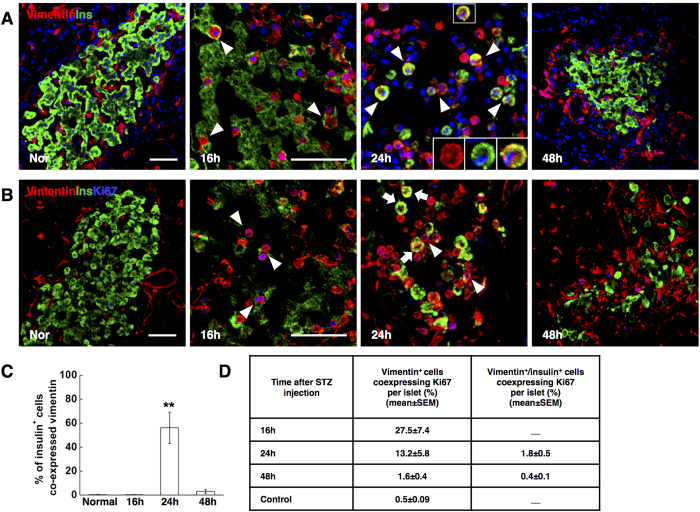
Neogenic beta-cells manifested vimentin expression.(A) Photomicrographs double stained with anti-insulin (green) and anti-vimentin (red) antibodies from normal control rats (Nor), and STZ-treated rats at different time points (16 h, 24 h, 48 h). Nuclei were labeled with DAPI. Scale bars, 50 μm. The isosceles triangle: insulin+ cells co-expressing vimentin. The boxed regions showed the high power photomicrograph at the bottom right of the image. (B) Photomicrographs triple stained with anti-vimentin (red), anti-insulin (green) and anti-Ki67 (blue) antibodies. The isosceles triangle: vimentin+ cells co-expressing Ki67. The arrows: vimentin+/insulin+ cells showing negative Ki67 expression. Scale bars, 50 μm. (C) Quantification of insulin positive cells co-expressing vimentin. (D) Quantification of vimentin+ and vimentin+/insulin+ cells co-expressing Ki67. Data are shown as means ± SEM, n = 5–6 per group; *P < 0.05 and **P < 0.01.